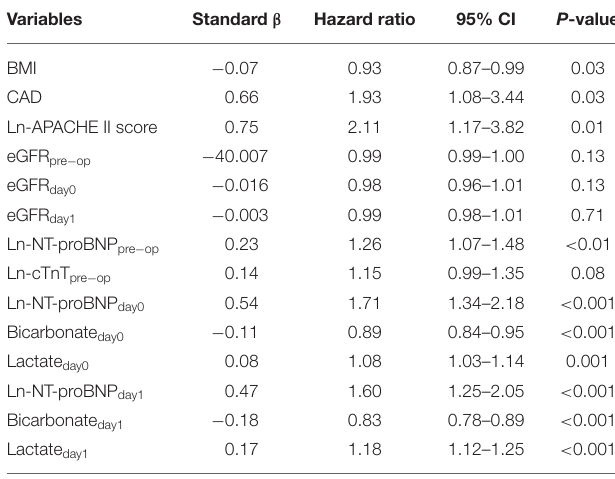
TABLE 5 | Predictors of 28-day mortality by univariate Cox regression analysis.